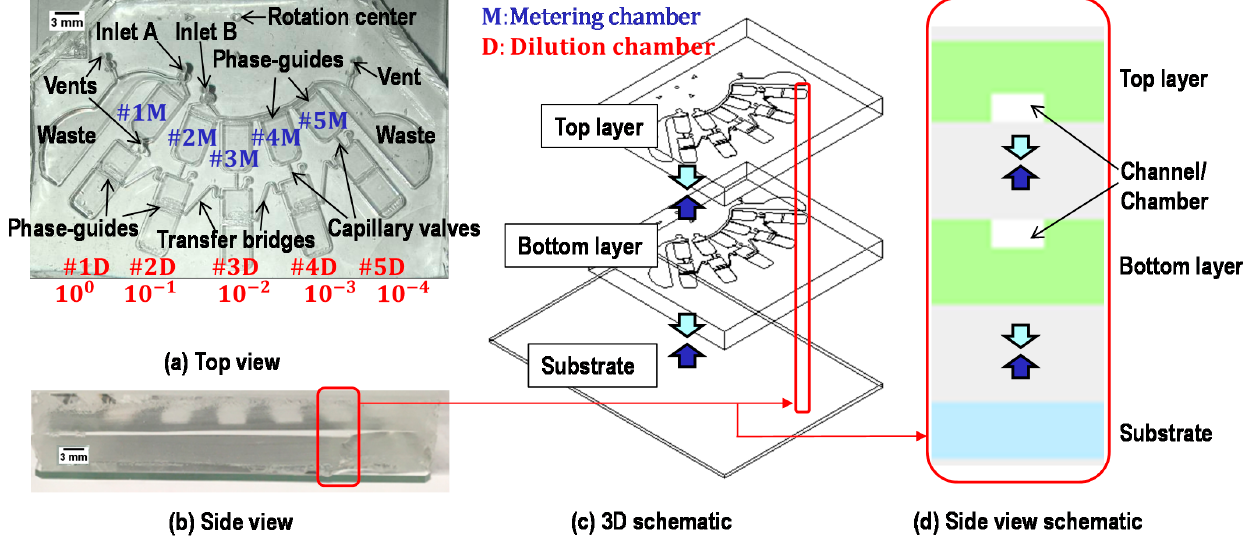
Figure 3. Device images and schematics. Metering chambers corresponding to serial dilutions with 10 0 , 10 − 1 ,10 − 2 , 10 − 3 , and 10 − 4 concentrations are labeled as #1M, #2M, #3M, #4M, and #5M, respectively. Dilution chambers corresponding to serial dilutions with 10 0 ,10 − 1 ,10 − 2 ,10 − 3 , and 10 − 4 concentrations are labeled as #1D, #2D, #3D, #4D, and #5D, respectively. There are three vents in total; two vents in the waste chambers are used for sample metering, and one vent in #1D is used for sample transfer.